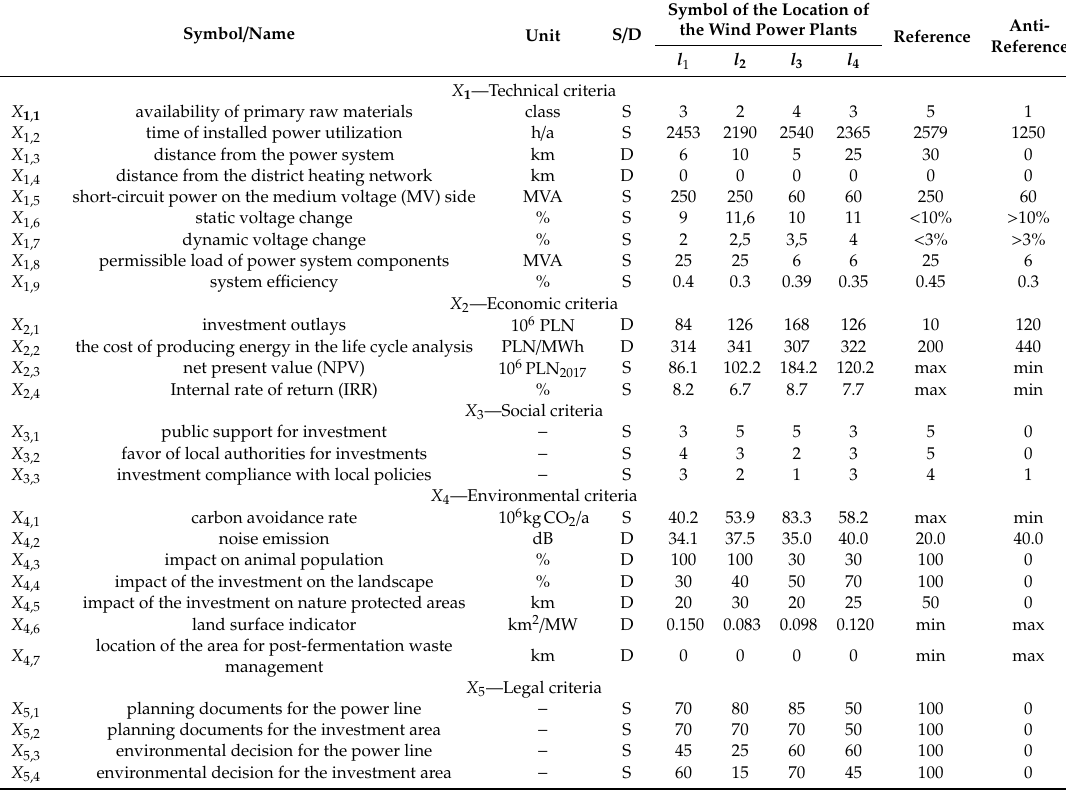
Table 8. The assumptions for the comparative analysis of the location of wind power plants.